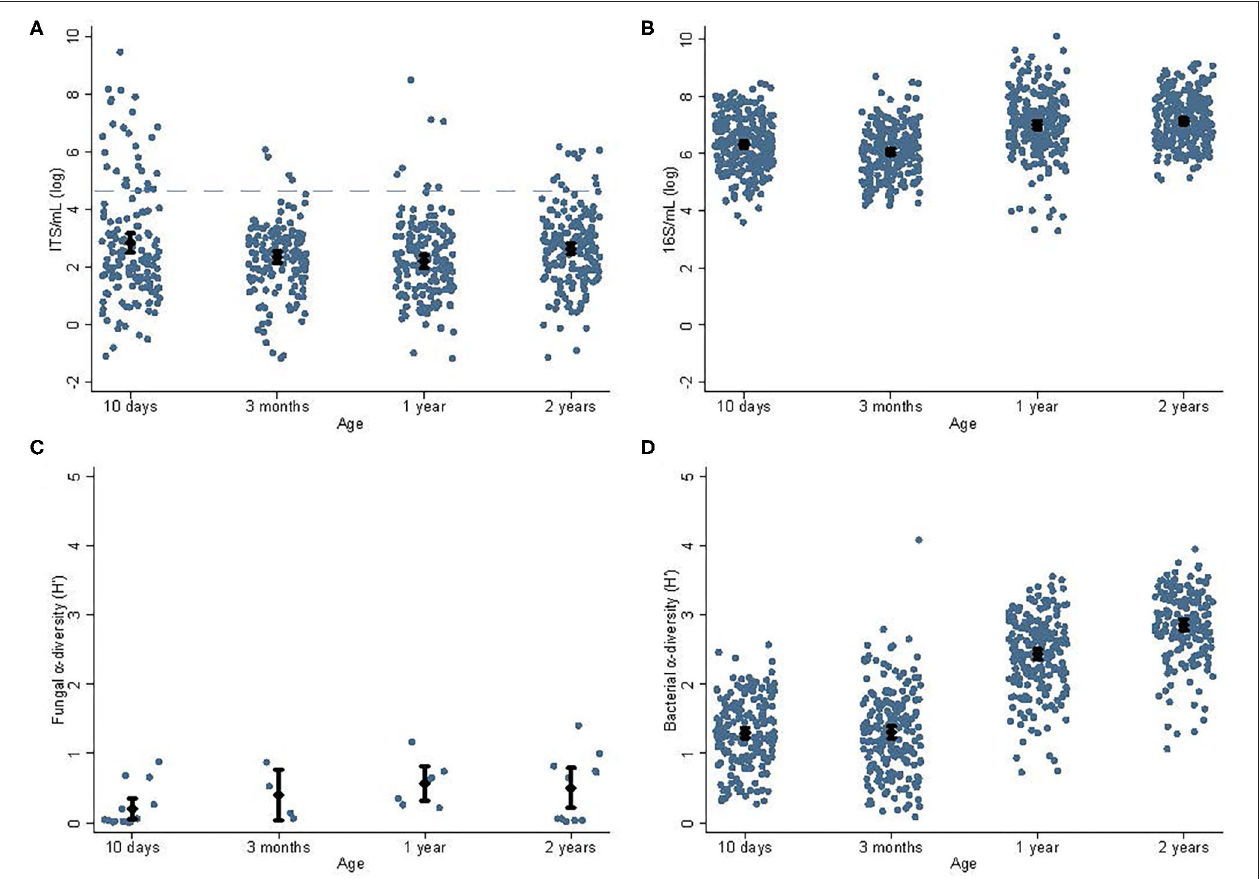
FIGURE 1 | Abundances and alpha diversities for fungi and bacteria. Abundance and alpha diversity data for fungi and bacteria for children’s samples at different ages [10 days, 3 months, 1, and 2 years; fungal data reported in ( 15)]. The average fungal abundances (A) decreased significantly ( P = 0.01) from 10 days (2.83 log ITS/ml) to 1 year (2.19 log ITS/ml). The dashed blue line indicates the sequencing cut-off for fungi. Similarly, the bacterial abundance (B) decreased significantly ( P = 0.04) from 10 days (6.31 log 16S/ml) to 3 months (6.06 log 16S/ml), and then increased toward 1 year (7.00 log 16S/ml, P < 0.01). There was insufficient data to determine the effect of age on the fungal alpha diversity (C) ; however, bacterial alpha diversity (D) increased steadily from its lowest at 10 days (1.30 H ′ ) and highest at 2 years (2.86 H ′ , P < 0.01). Cesarean section was associated with a non-significant trend toward lower bacterial alpha diversity at 3 months of age (1.09 vs. 1.36 H ′ , P = 0.06). Diamonds indicate sample means and error bars cover the 95%